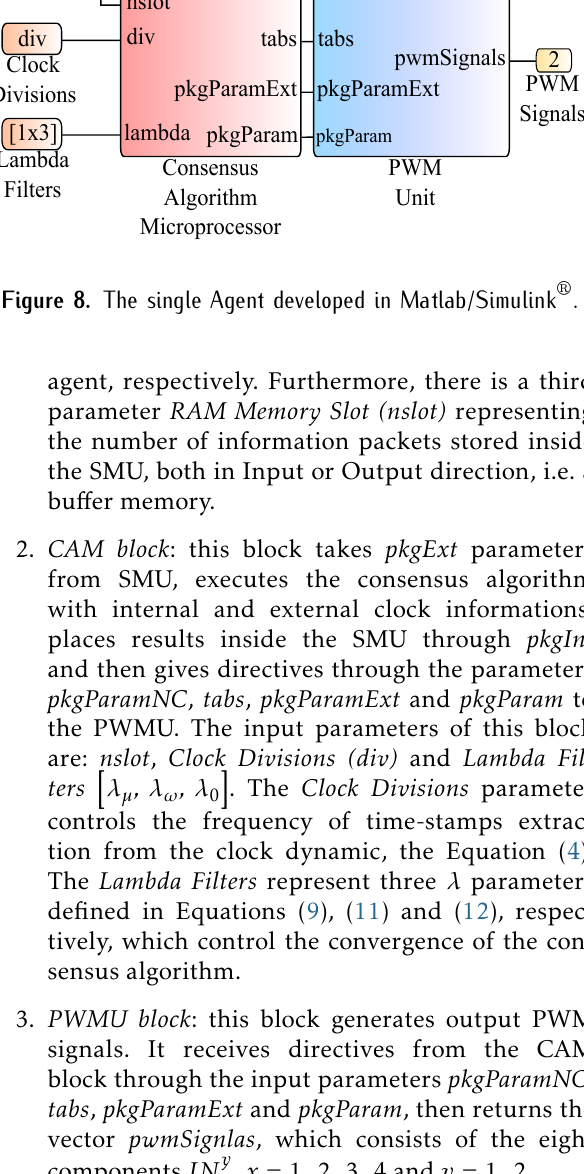
Figure 7. The ACU detail.